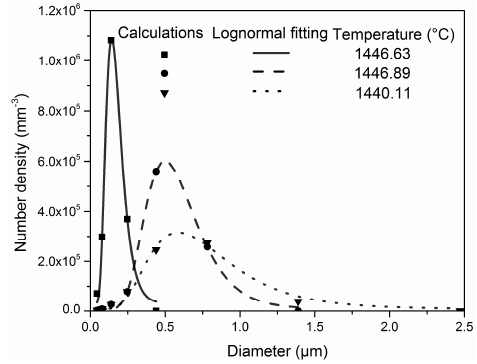
Figure 11. Evolutions of the size distribution of MnS [64].